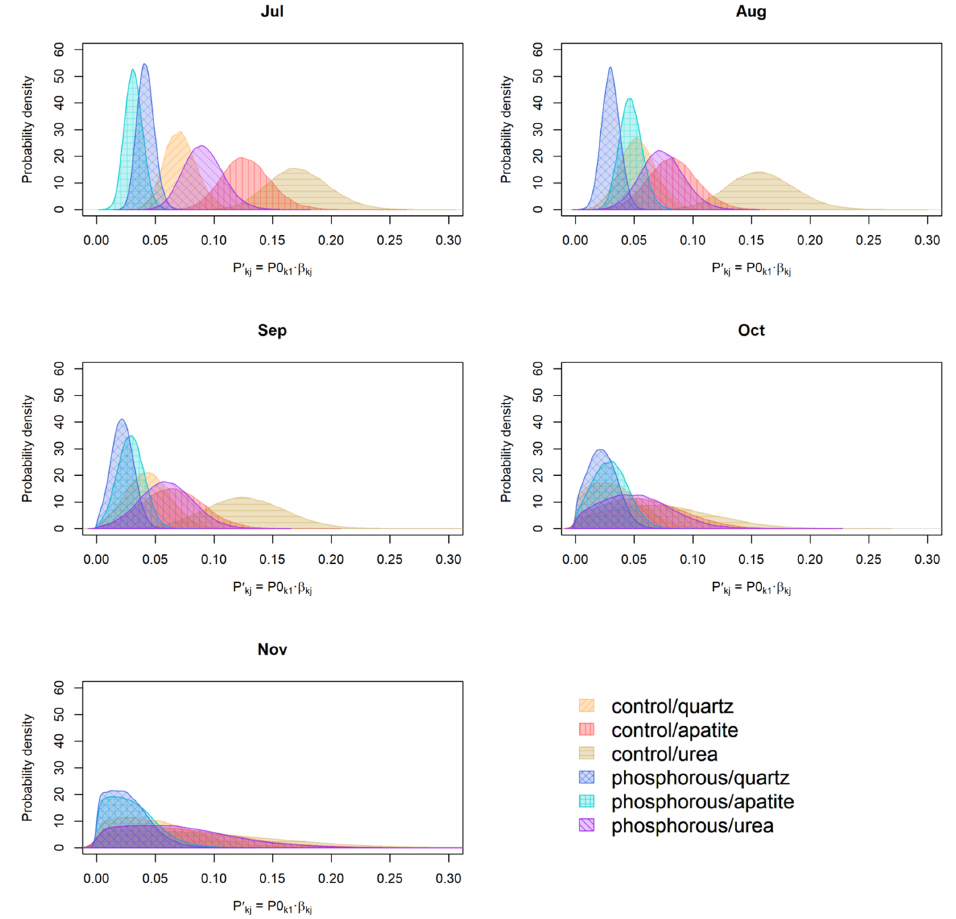
Figure 6. Probability distribution of P (cid:48)